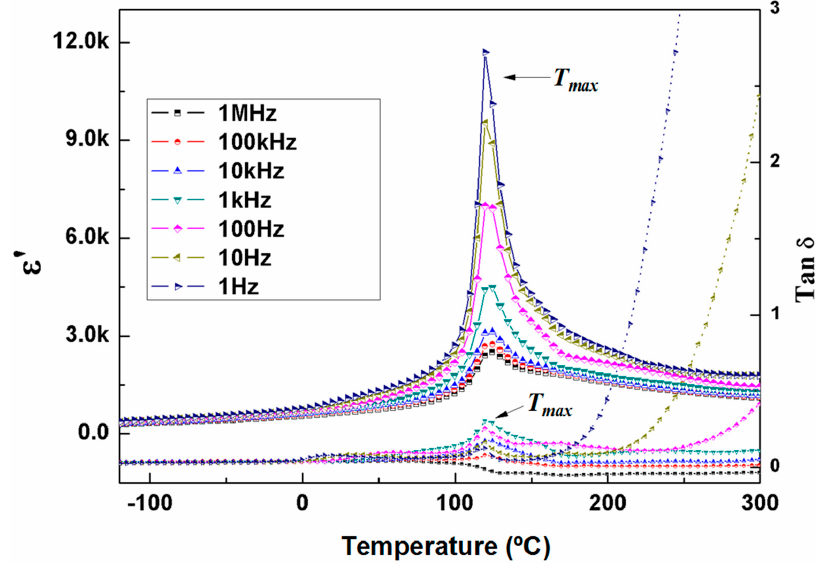
Figure 6. The temperature dependence of the dielectric constant ( ε′ ) and the loss tangent (tan δ ) at various frequencies for unpoled [111]-oriented plates.